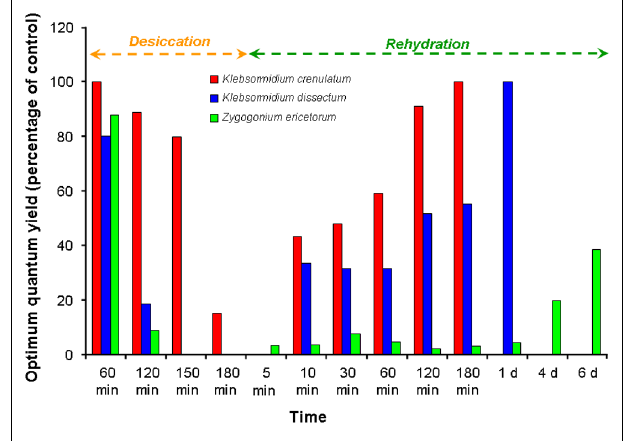
FIGURE 3 |The effect of desiccation and rehydration on the optimum quantum yield (Fv/Fm) in Klebsormidium crenulatum and Klebsormidium dissectum isolated from an alpine biological soil crust, and in Zygogonium ericetorum collected from an adjacent intermittent streamlet (data adapted from Karsten etal., 2010; Karsten and Holzinger, 2012;Aigner etal., 2013).